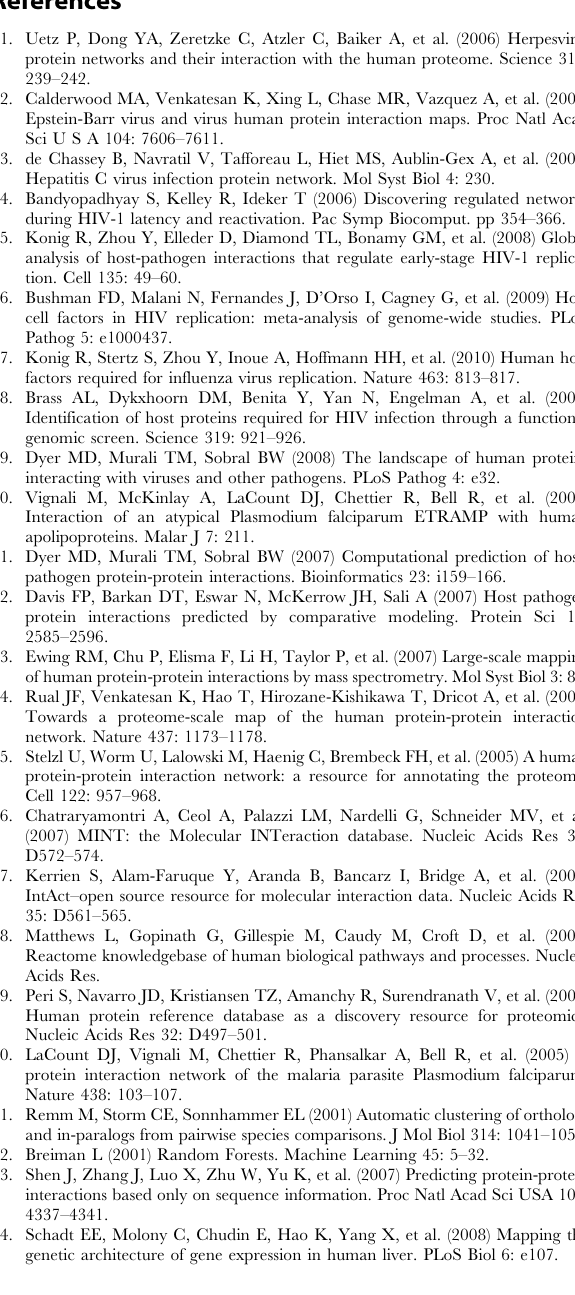
Table S5 100 most enriched GO biological processes of host proteins that interact with parasite proteins in the combined set of host-parasite